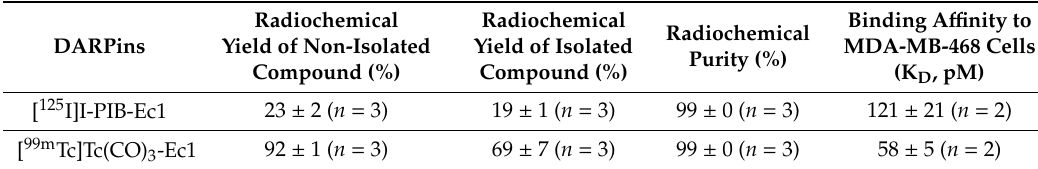
Table 1. Labeling and characterization of radiolabeled Ec1 variants.